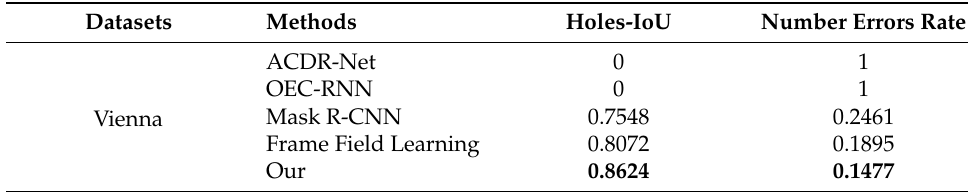
Table 2. Quantitative evaluation results of